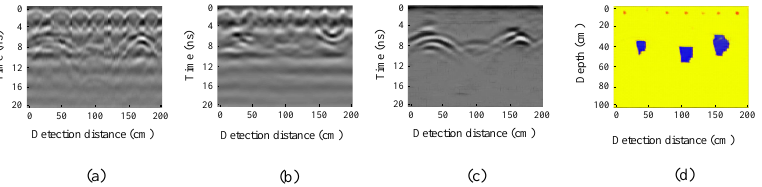
Figure 10. Inversion results of the laboratory experiment: ( a ) original B-scan GPR image, ( b ) migrated GPR image, ( c ) the deep-learning-processed GPR image, and ( d ) the inverted permittivity map using the proposed